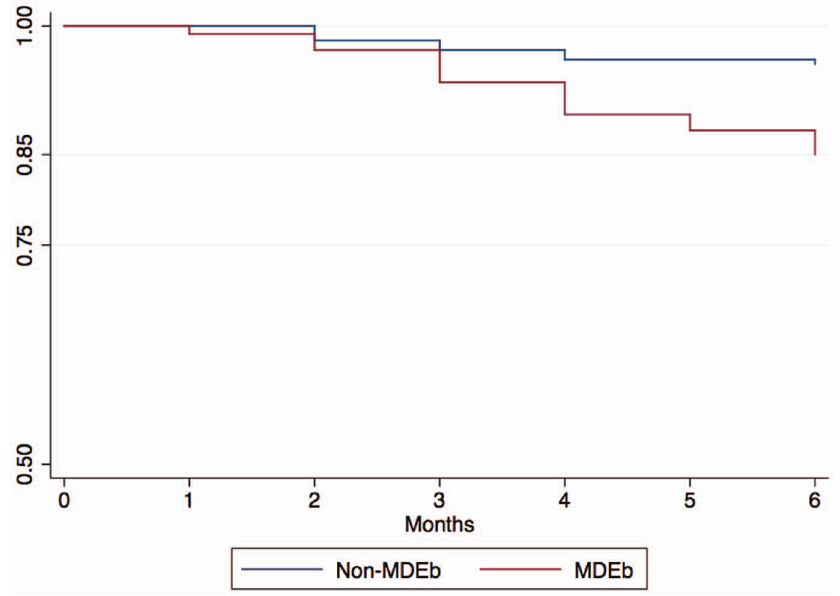
Figure 2. Negative Outcomes Survival Kaplan-Meier curve by MDE at baseline. doi:10.1371/journal.pone.0069514.g002 PLOS ONE |